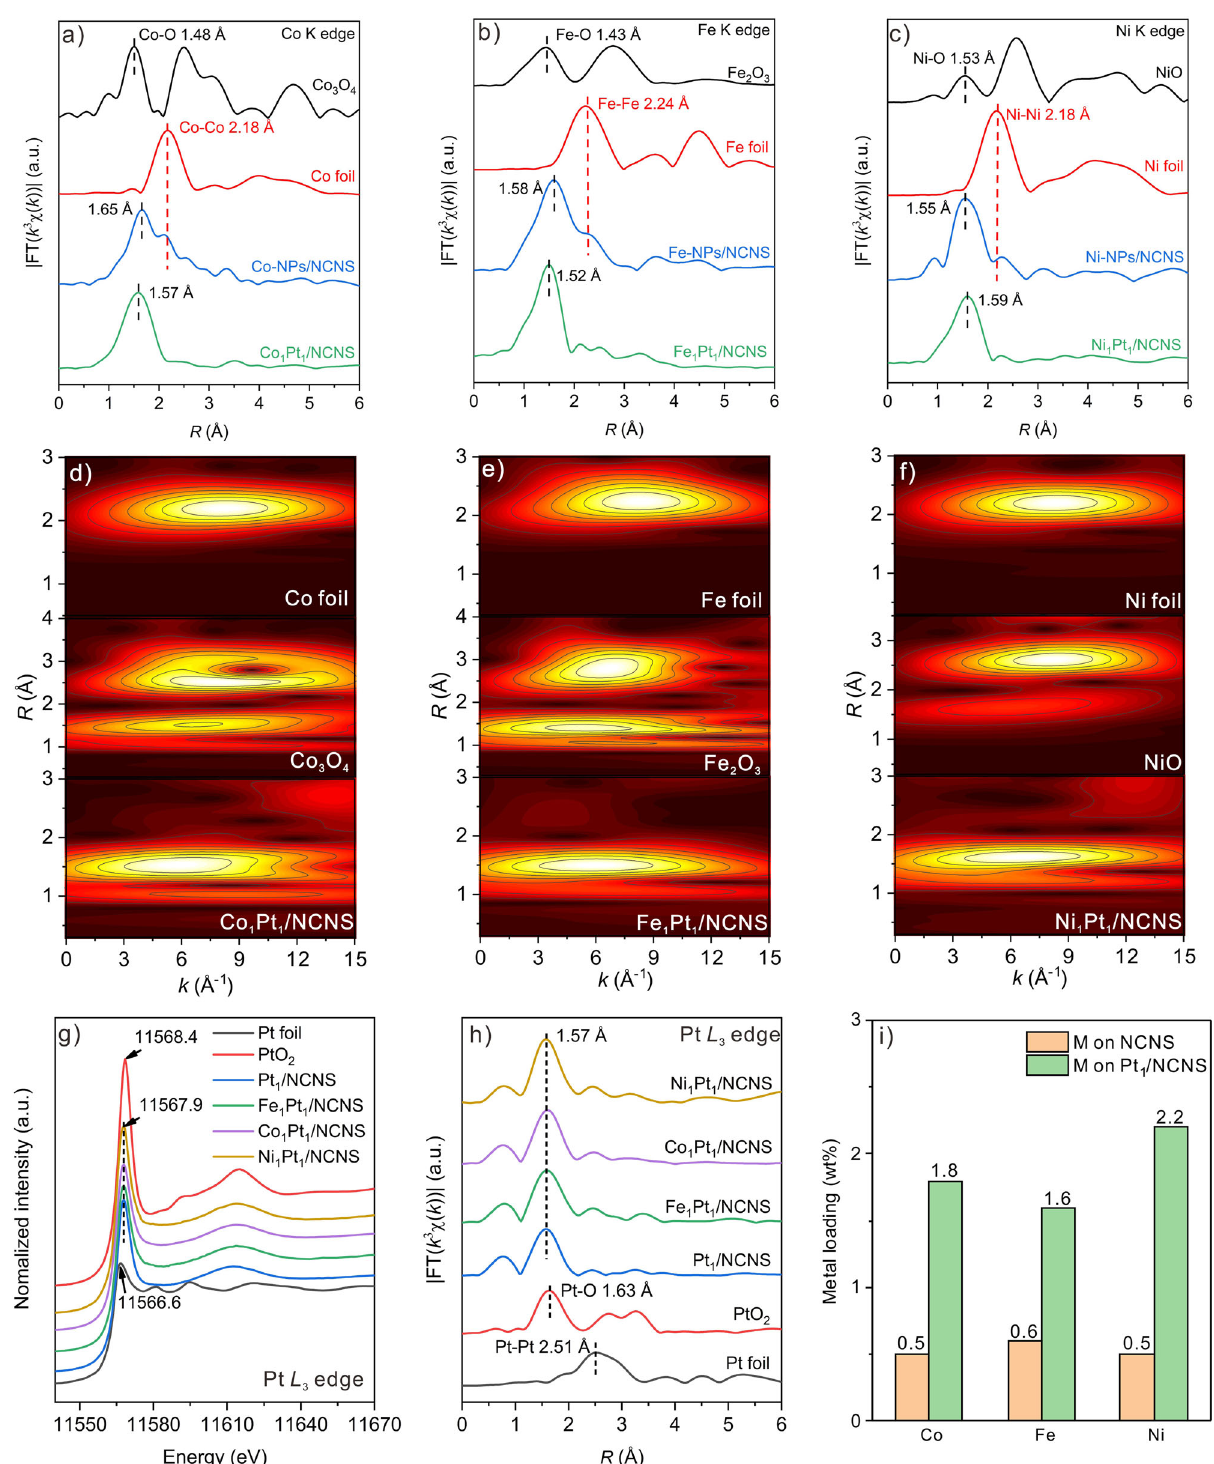
Fig. 2 XAS characterizations for M 1 Pt 1 /NCNS catalysts. a – c Radial distribution curve from FT-EXAFS of Co-NPs/NCNS, Co 1 Pt 1 /NCNS, Fe-NPs/NCNS, Fe 1 Pt 1 /NCNS, Ni-NPs/NCNS, and Ni 1 Pt 1 /NCNS, respectively, as well as their corresponding foil and oxide reference at Co, Fe, and Ni K edges. d – f Wavelet- transformed spectra of Co 1 Pt 1 /NCNS, Fe 1 Pt 1 /NCNS, Ni 1 Pt 1 /NCNS, as well as their corresponding foil and oxide reference at Co, Fe, and Ni K edges. g and h XANES and FT-EXAFS of Pt 1 /NCNS, Co 1 Pt 1 /NCNS, Fe 1 Pt 1 /NCNS, and Ni 1 Pt 1 /NCNS, respectively, as well as Pt foil and PtO 2 reference at Pt L 3 edge. i ICP- OES results of M (Fe, Co, and Ni) metal